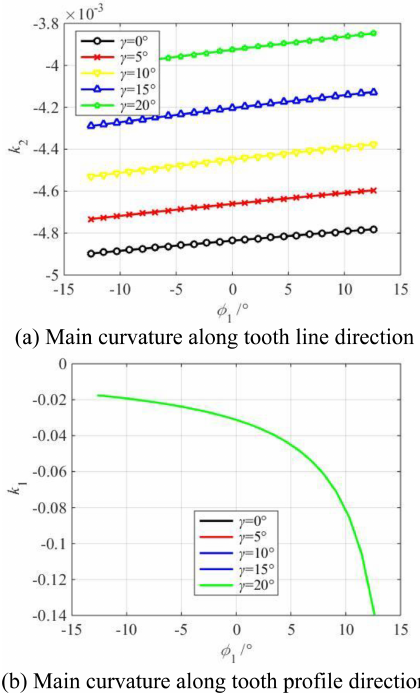
Figure 8. Influence of cutter inclination angle γ on main curvature of modified convex tooth surface.